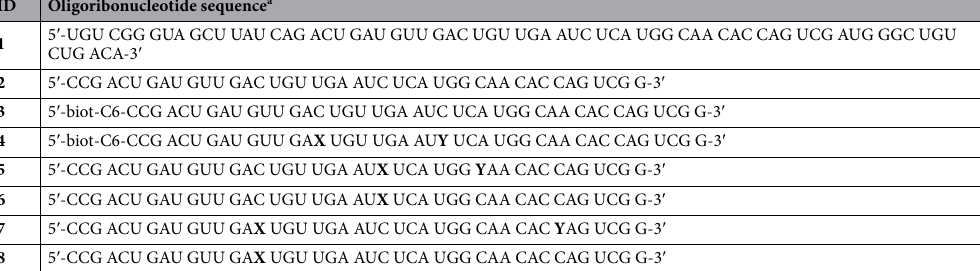
Table 1. Sequences of oligoribonucleotides used in this study. a Biot-C6 denotes 6-(5-((3a S ,4 S ,6a R )-2- oxohexahydro-1 H -thieno[3,4-d]imidazol-4-yl)pentan-amido)hexyl phosphate. X denotes the fluorescent FRET donor tC O and Y denotes the non-emissive FRET acceptor tC nitro . Oligoribonucleotide 1 is the full- length pre-miR-21. Oligoribonucleotide 2 is unmodified 43 nt pre-miR-21 hairpin used in ITC experiments. Oligoribonucleotide 3 is biotin-labelled unmodified 43 nt pre-miR-21 hairpin used in SPR experiments. Oligoribonucleotide 4 is biotin-labelled FRET pair modified 43 nt pre-miR-21 hairpin used in SPR. Oligoribonucleotides 5 – 8 are FRET pair or FRET donor modified 43 nt pre-miR-21 hairpins used in FRET